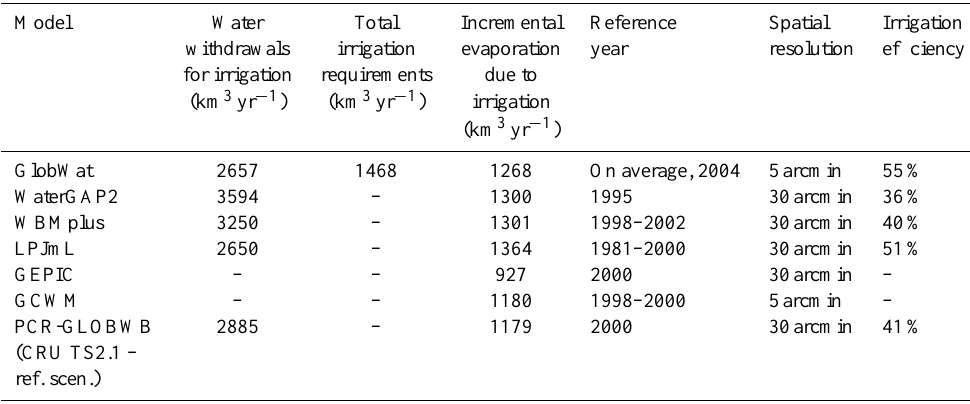
Table 8. Global water use in agriculture as calculated by different